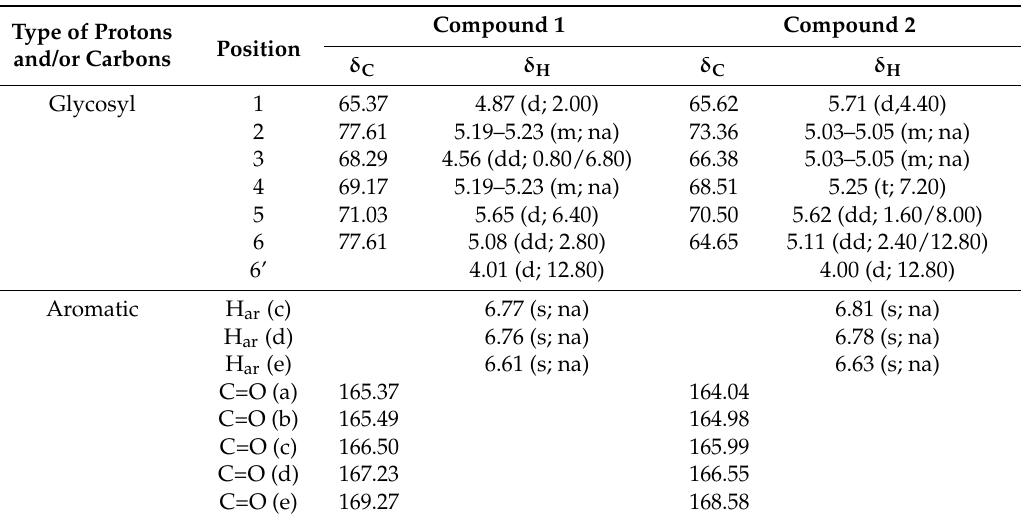
Table 2. 1 H and 13 C-NMR data (at, respectively, 400 and 100 MHz) for compound 1 and compound 2; chemical shifts ( δ ) are expressed in ppm and coupling constant (J) in